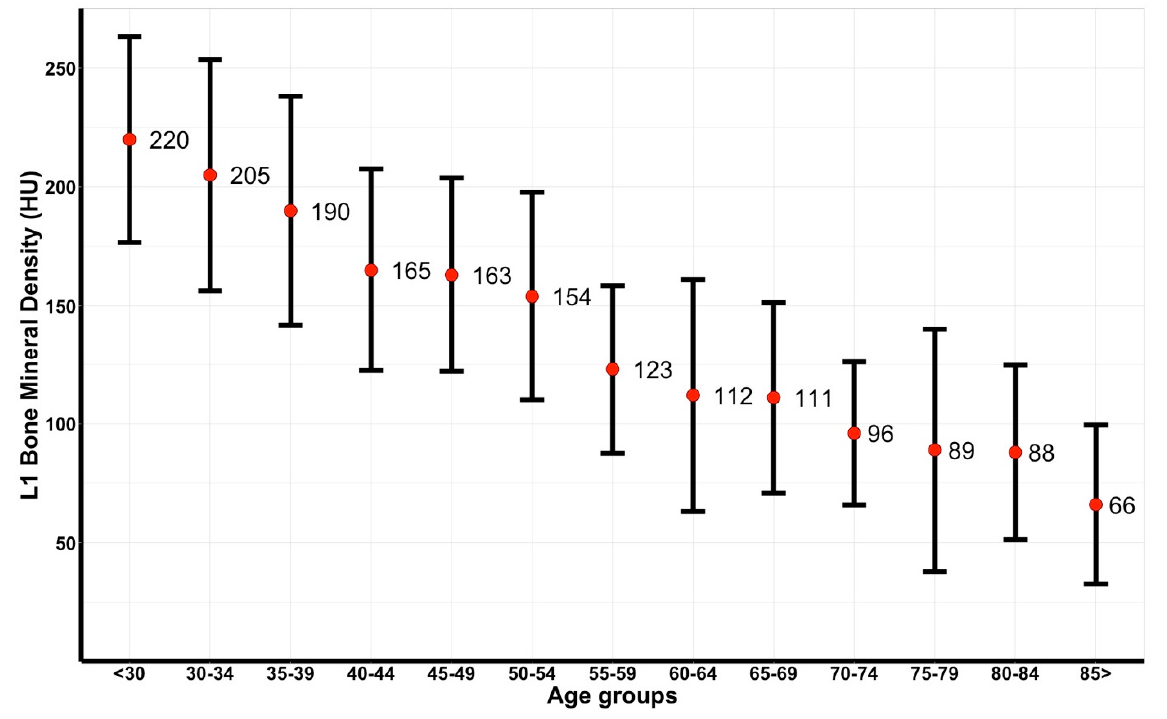
Figure 1. Errorbar plot of bone mineral density (in Hounsfield Units [HU]) in the total Dutch cohort, displayed in mean and standard deviation.